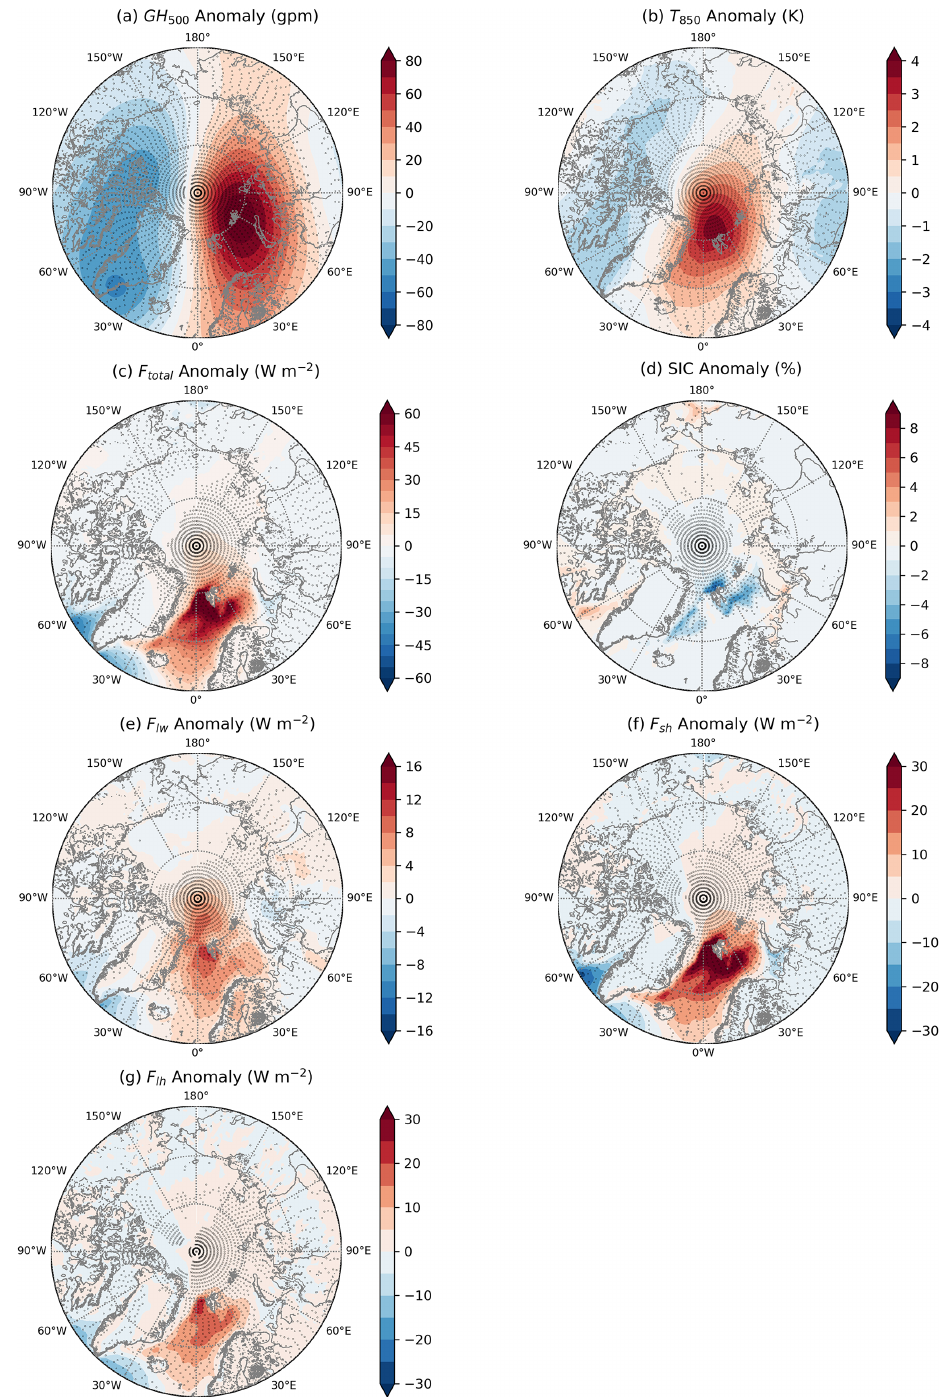
Figure 7. Anomalies of (a) 500hPa geopotential height (gpm), (b) 850hPa temperature (K), (c) F total , (d) SIC, (e) F lw , (f) F sh , and (g) F lh from linear regressions against daily f w time series over the Barents Sea. The stippling indicates statistical significance at the p < 0 . 05 level from a Student’s t